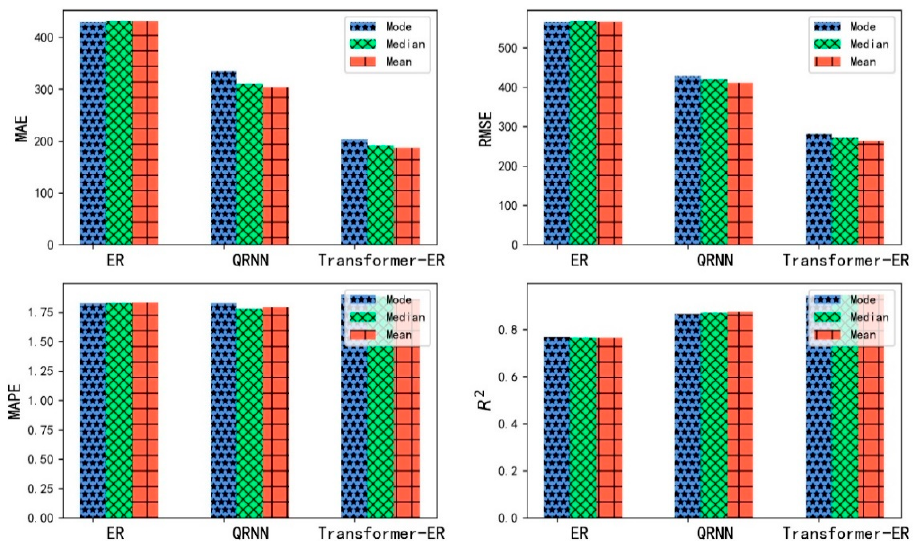
Figure 11. Evaluation metrics for point estimates constructed by the probability density prediction.